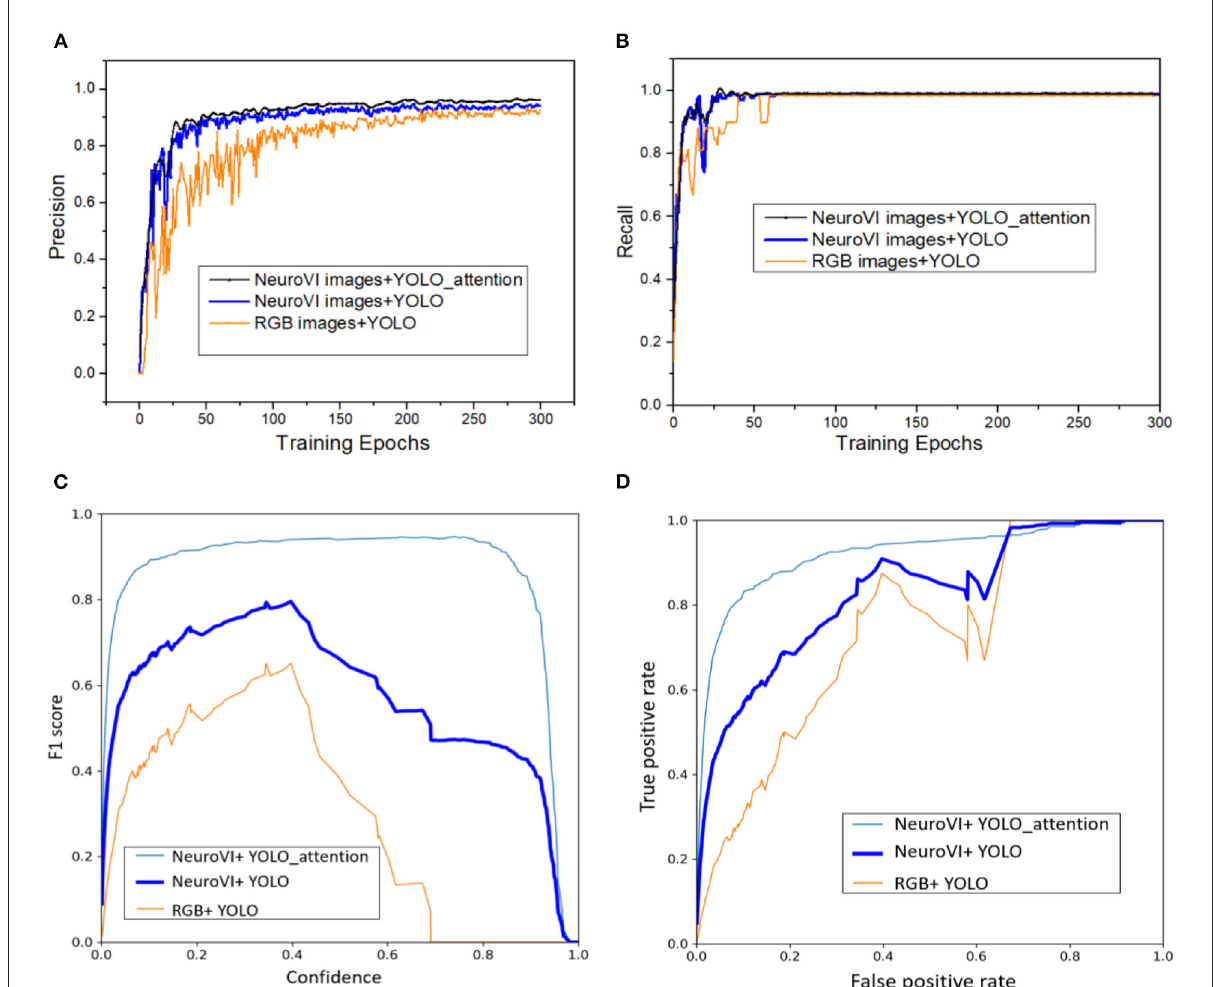
FIGURE6 The training comparisons among different datasets and networks. (A) The precision curves in training process. (B) The recall curves in training process. (C) The F1 scores curves with the different confidence. (D) The ROC curves with the validation dataset.